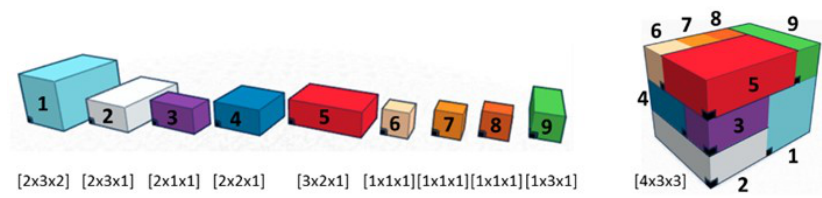
Figure 5. Meller’s scenario with containers and composite container.